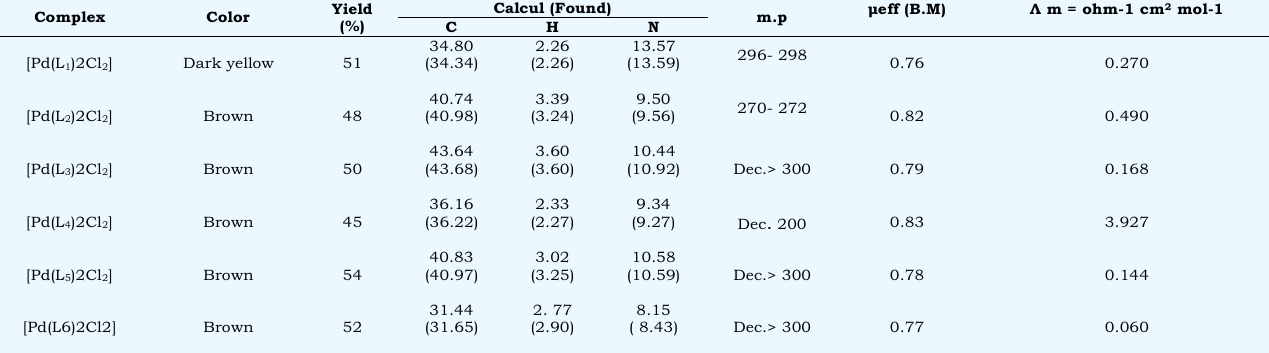
Table 1 Elemental analysis, color, yield. Magnetic susceptibility and conductivity data for the palladium complexes